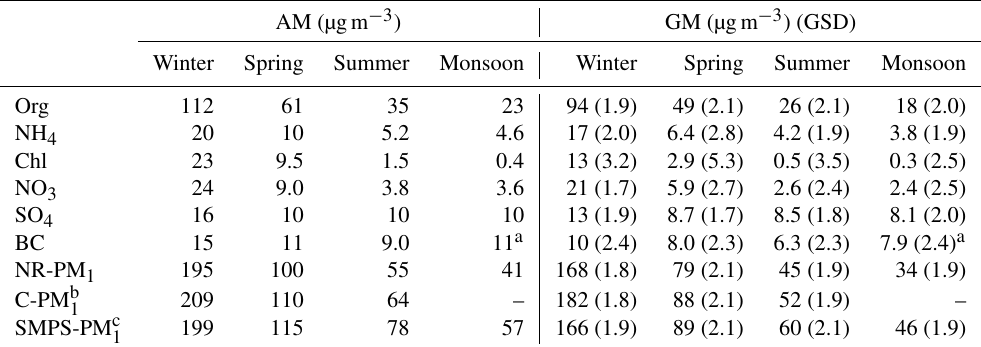
Table 1. Seasonal summary of PM 1 species – arithmetic mean (AM), geometric mean (GM), and geometric standard deviation (GSD) for hourly concentrations.